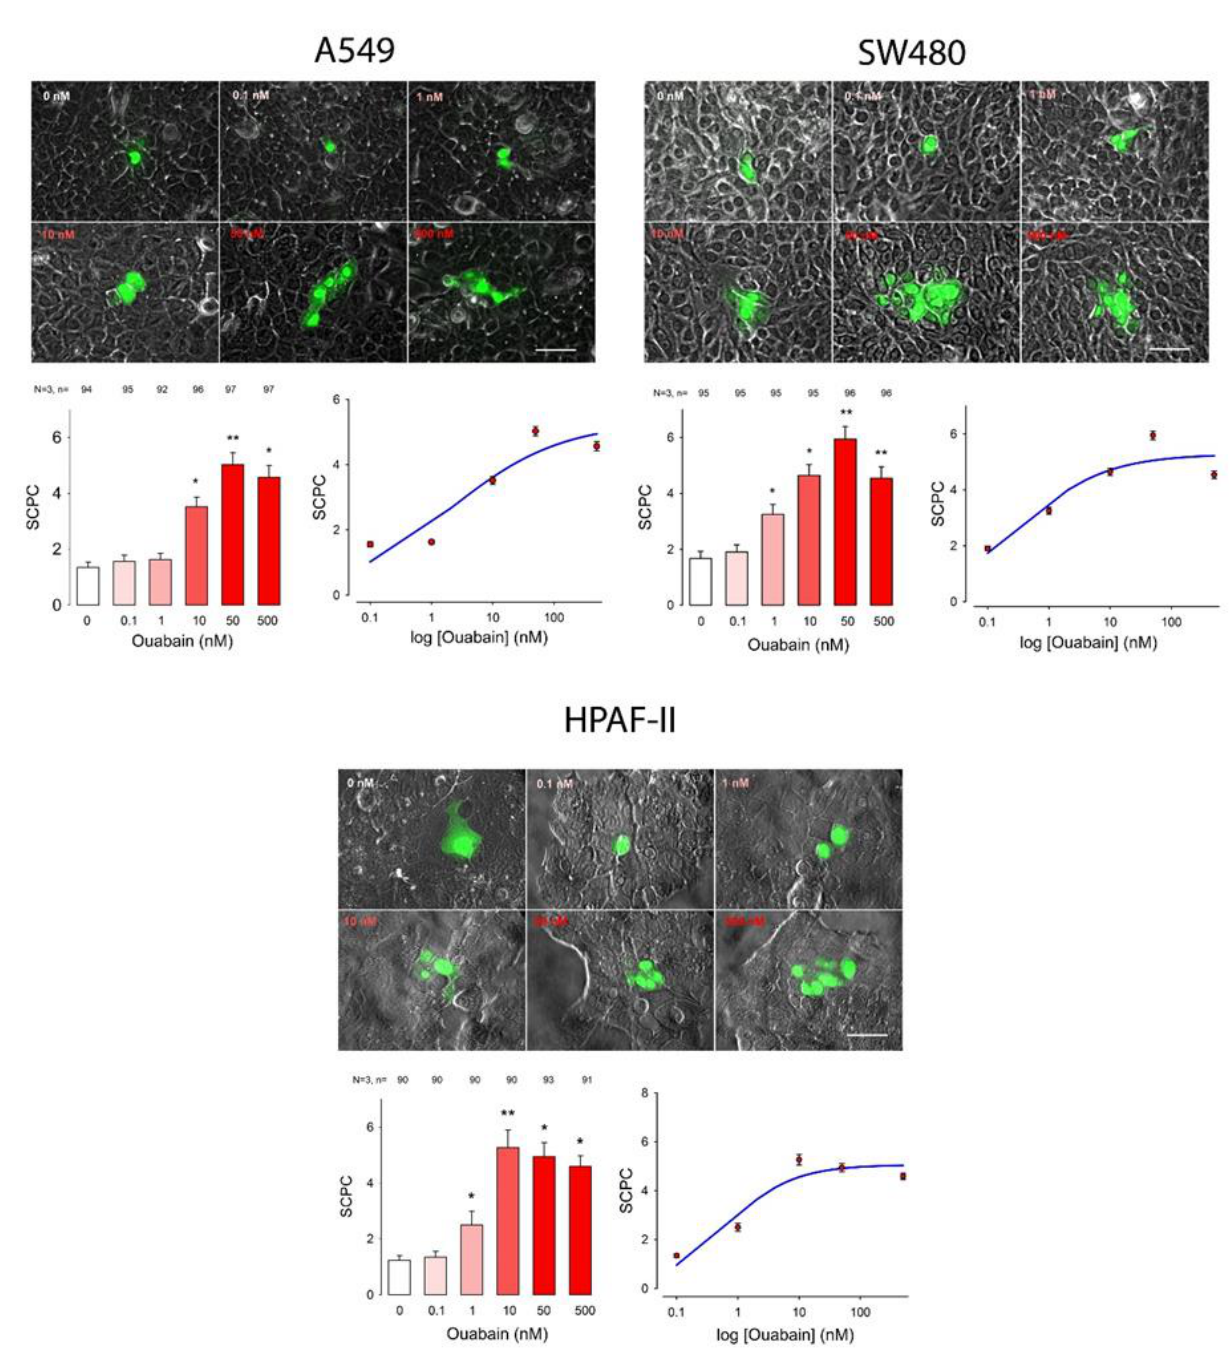
Figure 3. Effect of ouabain on GJIC in lung (A549), colon (SW480) and pancreas (Hpaf-II) cell lines. Each set shows, in the top part: representative images comparing the number of stained cell per cluster (SCPC) after one of them had been injected with Lucifer Yellow in monolayers that were either untreated (0 nM) or treated for one hour with ouabain in the concentration indicated (nM). In the bottom part: ( Left ) Histogram showing the mSCPC (± SE) in monolayers of confluent cells that were treated with ouabain, for one hour, in the concentrations indicated at the bottom of the bars. At the top of each bar the number of repeats after three independent trials is shown. Asterisks indicate a statistically significant difference compared to the control group, (Dunn’s method), * indicates p = < 0.05, ** indicates p = < 0.005). Scale bar length = 100 µM. ( Right ) A semi-log plot shows, the average data and the curve (blue) resulting after fitting data to a logistic equation.